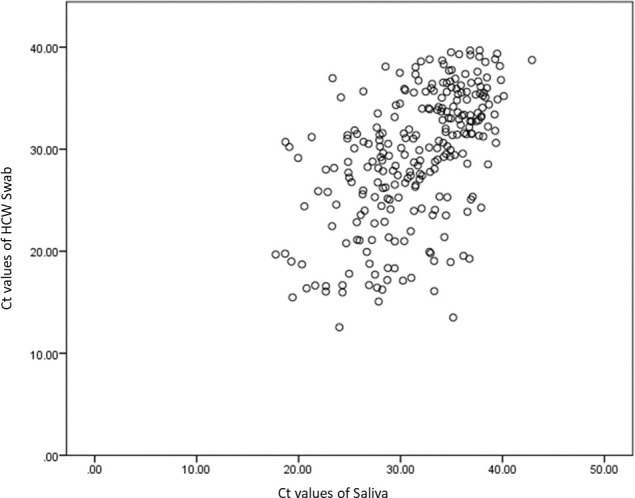
Correlation of Ct values of HCW swab and saliva.